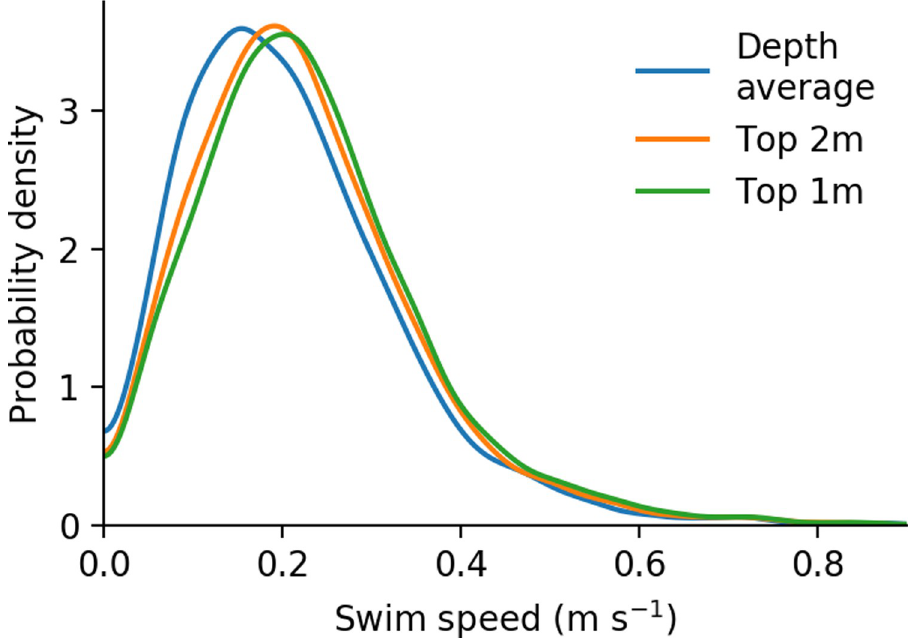
Fig 7. Distributions of swimming speed. Kernel density estimate of swimming speeds over all segments in the analysis region, relative to three assumptions of vertical distribution.